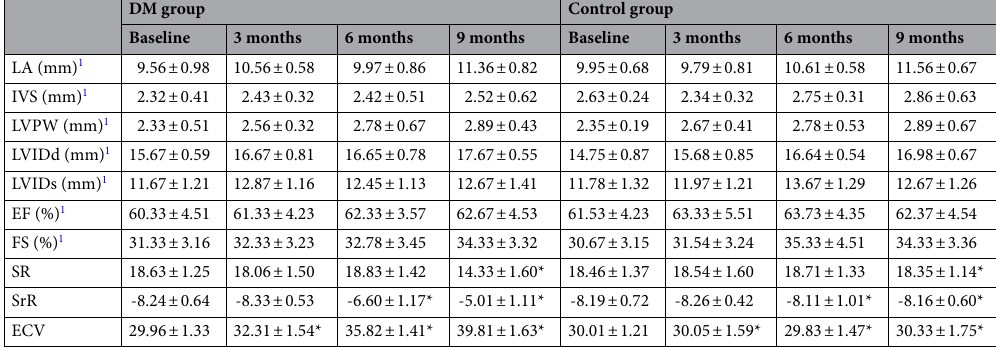
Table 1. Ultrasonography and CMR parameters. *p < 0.05 vs. the control group at the same time